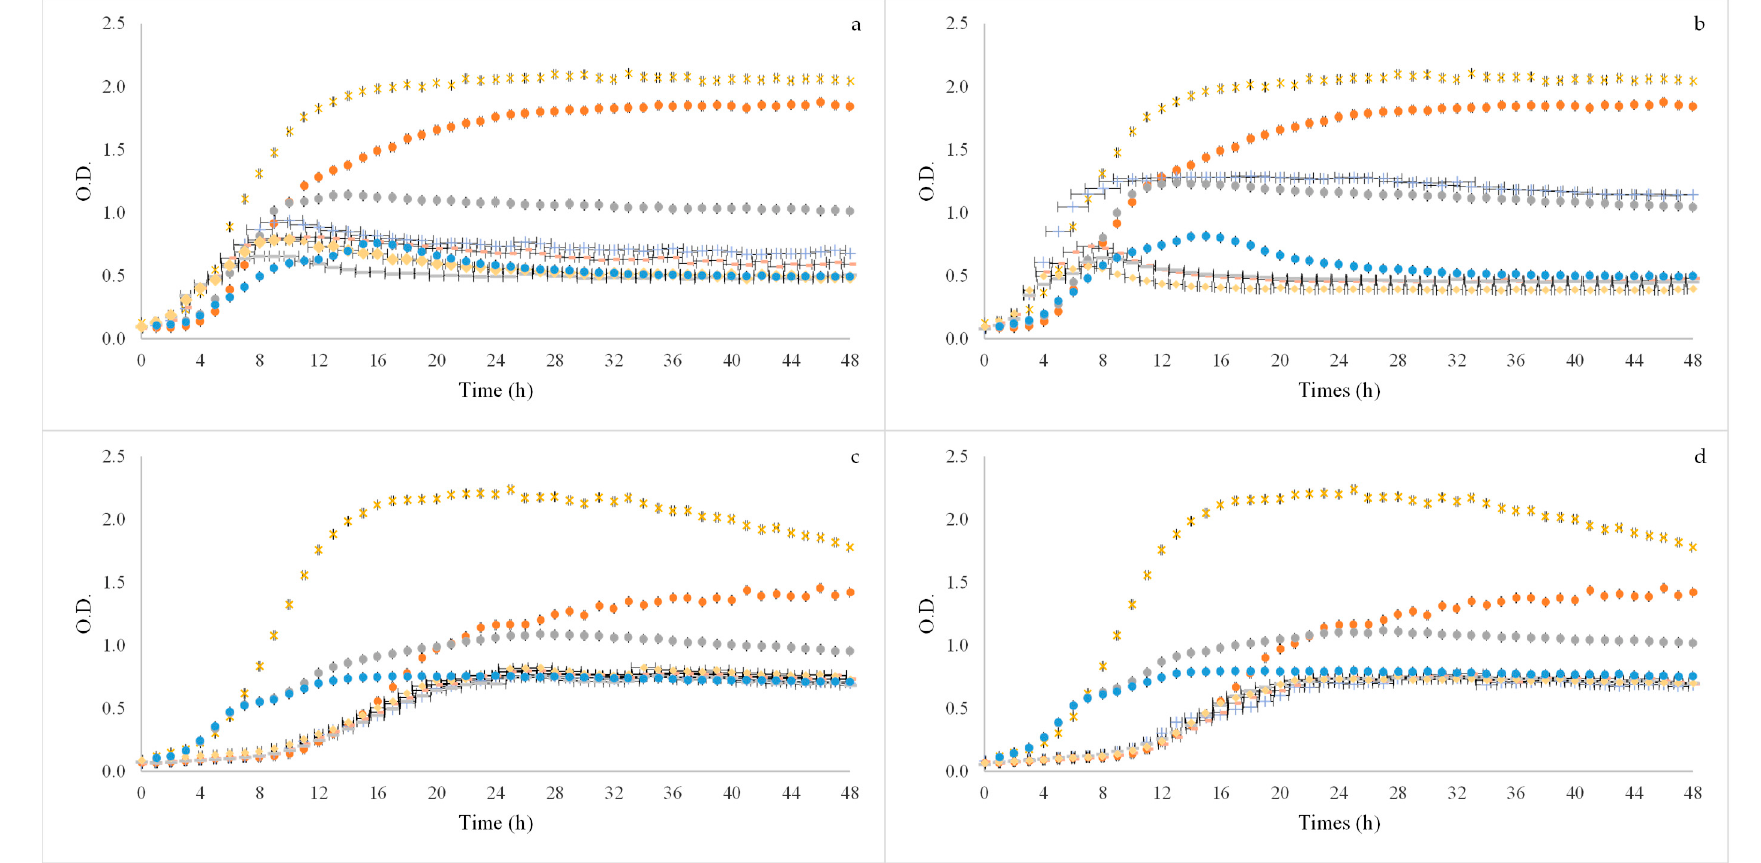
Figure 3. Growth curves of probiotic microorganisms Lacticaseibacillus casei 01 ( a , b ) and Lactobacillus acidophilus LA-5 ( c , d ) after applying BSG flours of SLE ( a , c ) and OHE ( b , d ) using three concentrations (2, 1.5 and 1% ( v/w )). x Positive control—Glucose; • Positive control—FOS; + 60% ethanol:water SLE or OHE_2% ( v/w ); - 60% ethanol:water SLE or OHE_1.5% ( v/w ); • 60% ethanol:water SLE or OHE_1% ( v/w ); - 80% ethanol:water SLE or OHE_2% ( v/w ); ⧫ 80% ethanol:water SLE or OHE_1.5% ( v/w ); • 80% ethanol:water SLE or OHE_1% ( v/w ). 80% ethanol:water SLE